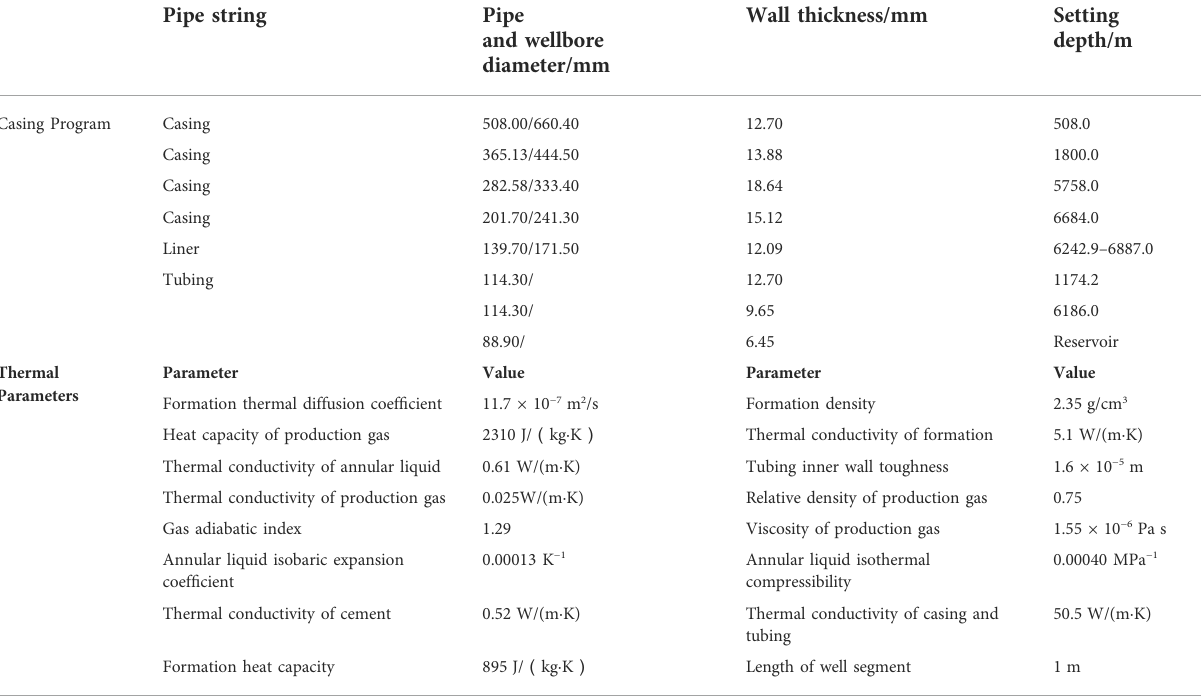
TABLE 1 Calculation parameters of the case